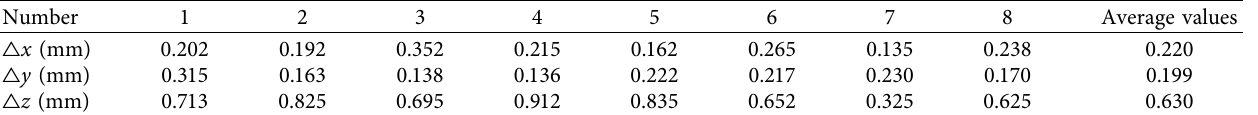
Figure 8: Procedure Table 5: Experimental data of the eye-to-hand binocular vision system positioning error.